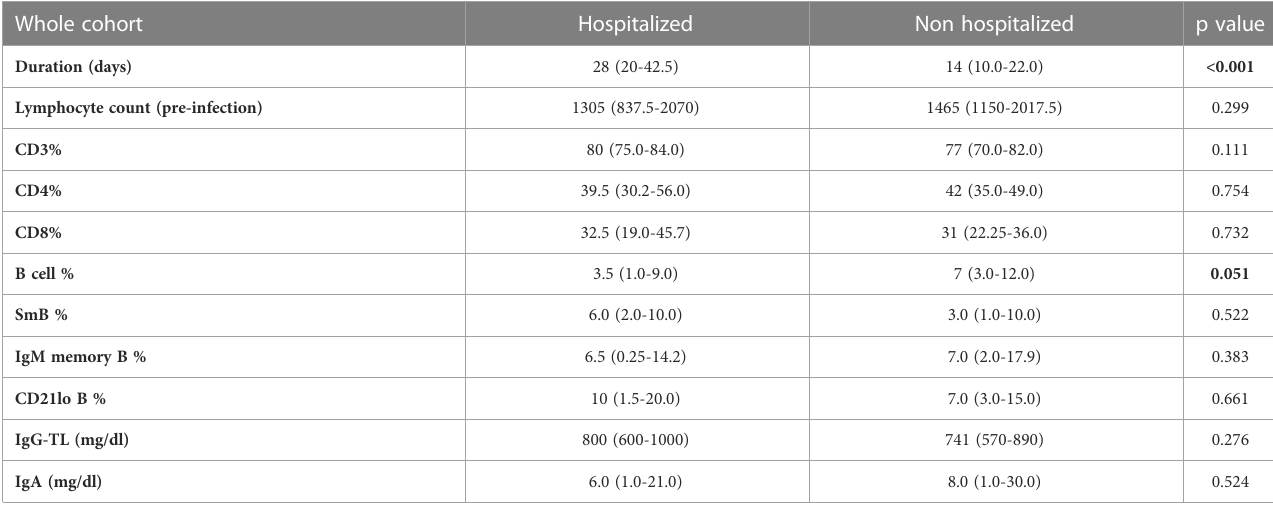
TABLE 5 Mann-Whitney U test for comparison of immunologic parameters between hospitalized and non-hospitalized patients in the whole CVID cohorts. Whole